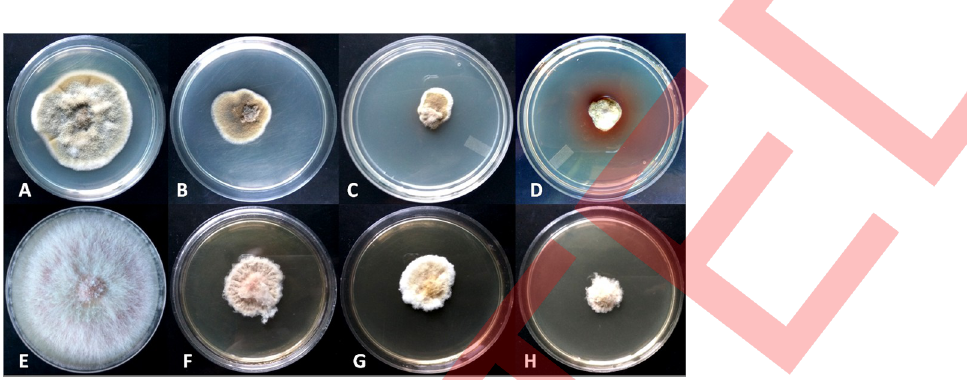
Fig 5. Antifungal activity of ethyl acetate extract of Aspergillus clavatonanicus strain MJ31against fungal phytopathogens. A: F . graminearum (control), B- D: antifungal activity of ethyl acetate extract against F . graminearum at 250 η g/ml, 500 η g/ml and 1000 η g/ml, E: F . culmorum (control), F-H: antifungal activity of ethyl acetate extract against F . culmorum at 250 η g/ml, 500 η g/ml and 1000 η g/ml.